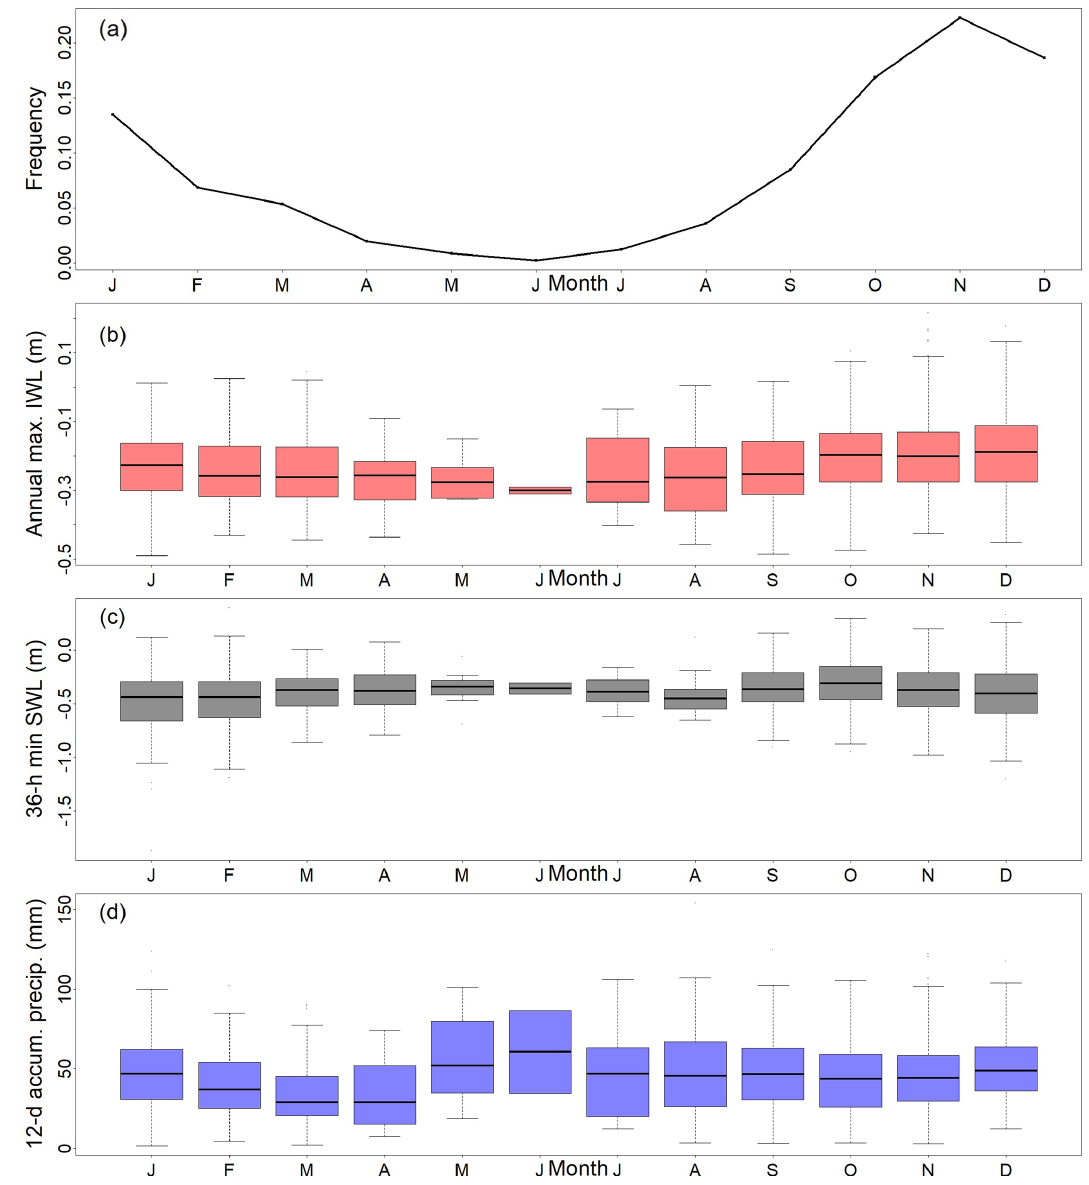
Figure 6. Frequency of WL max events occurring each month (a) , monthly mean of WL max (b) , S T